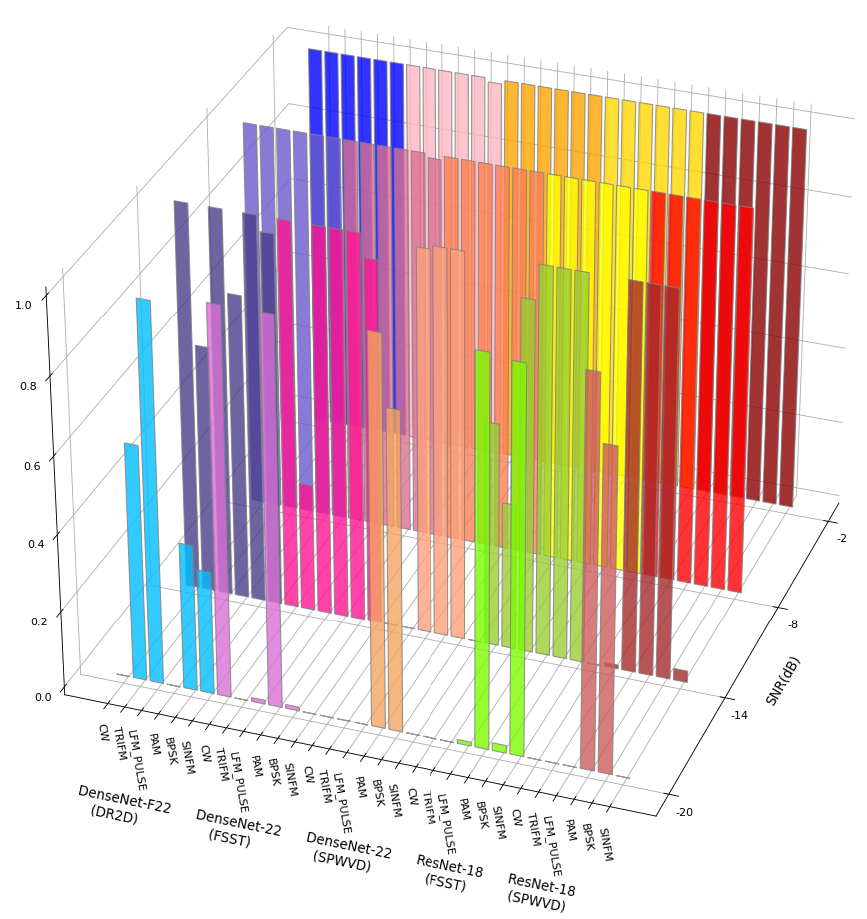
Figure 14. The recognition accuracy achievements for each modulation type in environments with different